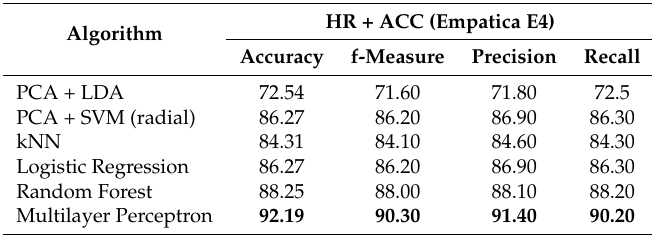
Table 5. Stress with context classification accuracy, f-Measure, precision and recall values with different ML algorithms: three-class. HR +ACC for Empatica